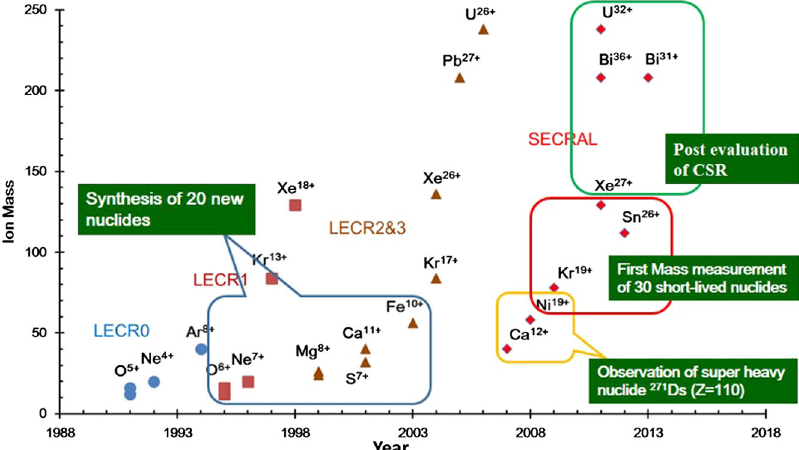
FIG. 31. Contributions of SECRAL and the normal conducting ECRIS at IMP to physics research based on the HIRFL accelerator.